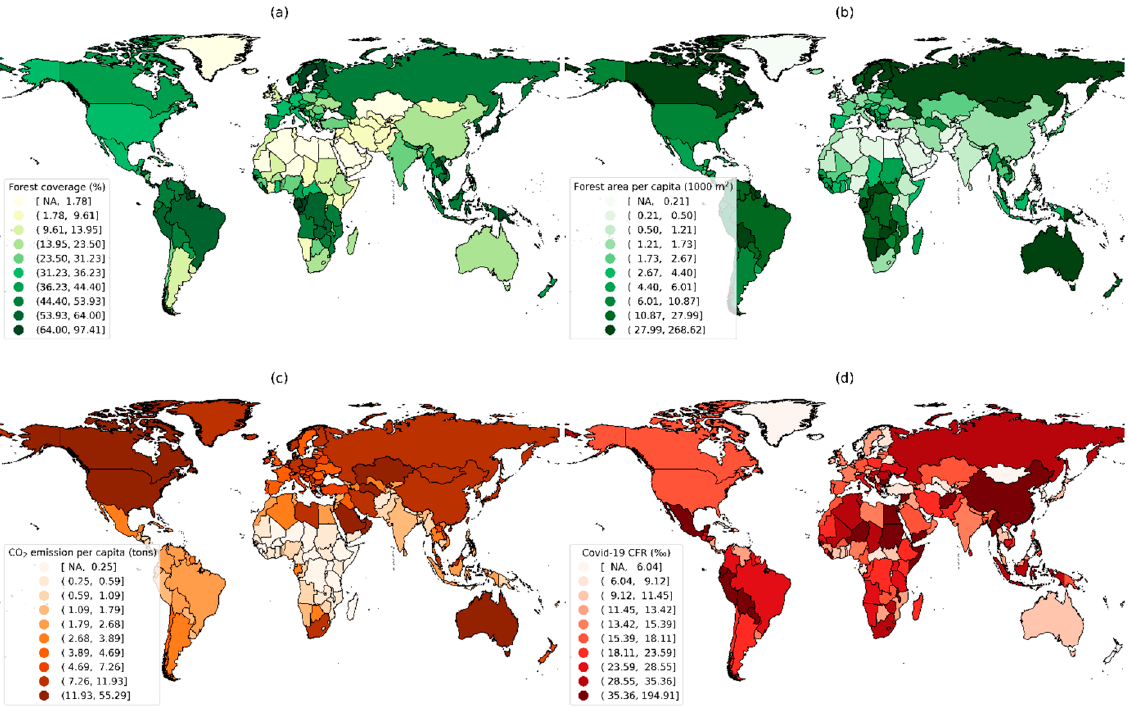
Figure 2. Global distribution of ( a ) forest coverage rate, ( b ) forest area per capita, ( c ) CO 2 emission per capita, and ( d ) COVID-19 CFR. CFR: case-fatality rate. NA: not available.